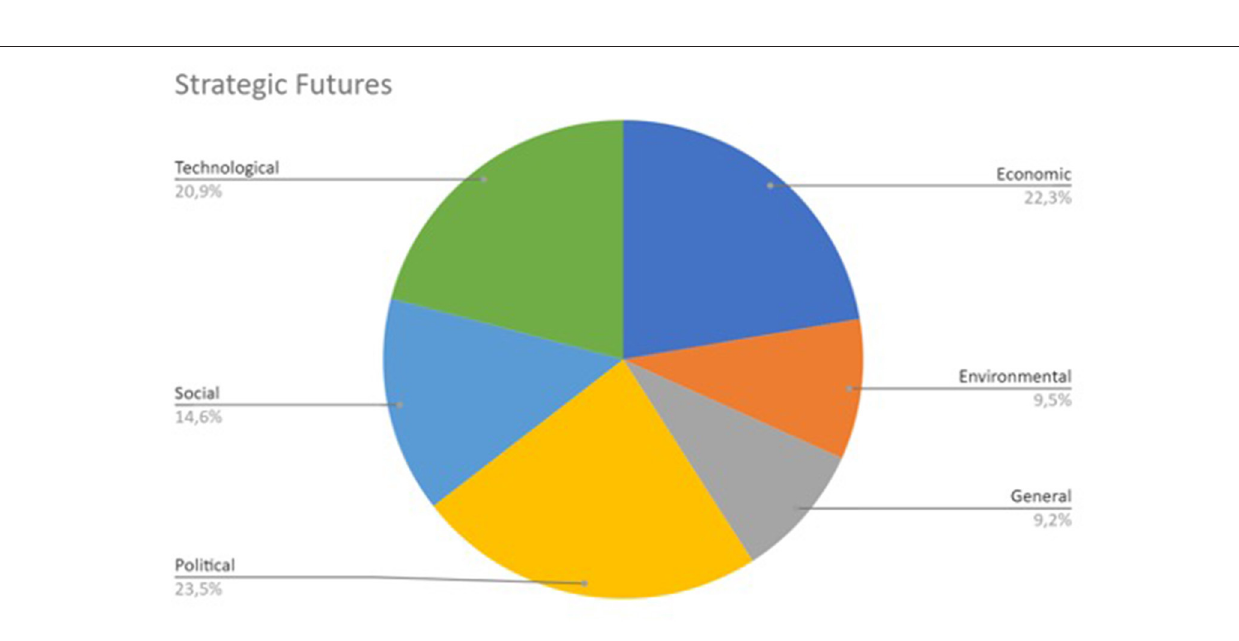
FIGURE 3 | Visualizing the different types of strategic futures and the topic: economic, environmental, social, political, general, and